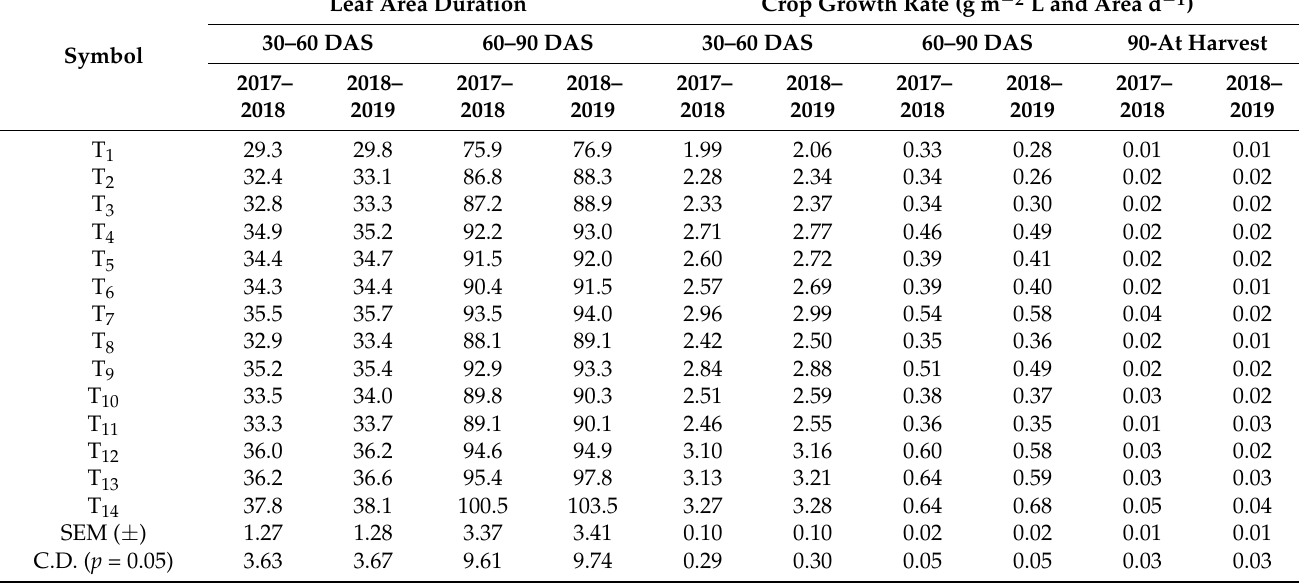
Table 2. Nutrient management strategies effects on leaf area duration and crop growth rate at various crop